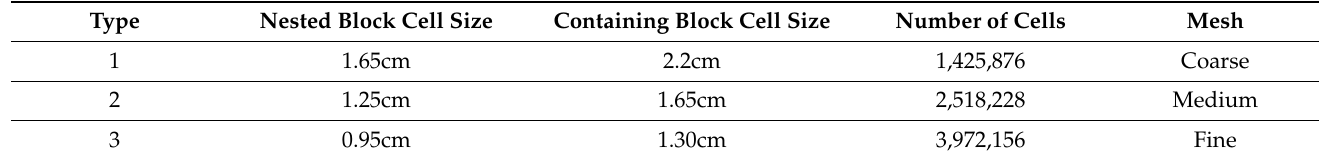
Table 2. Characteristics of the meshes tested in the convergence analysis.